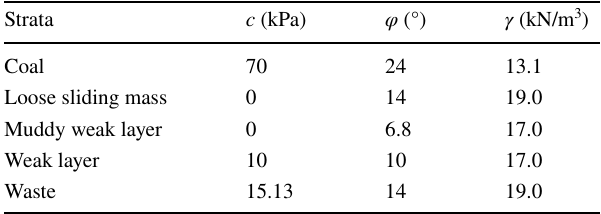
Table 1 Geotechnical physical mechanics